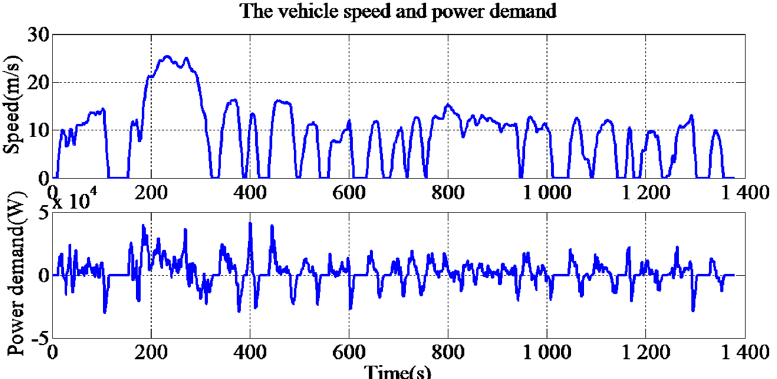
Figure 14. Speed and driveline power demand for Urban Dynamometer Driving Schedule (UDDS) drive cycle.